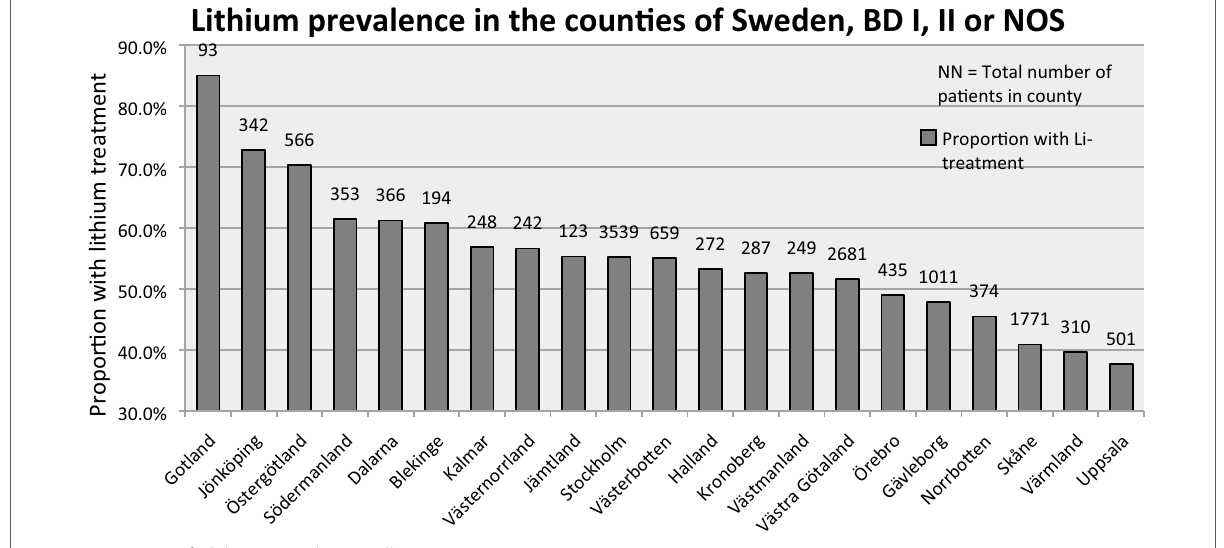
Fig. 2 County specific lithium prevalences. All BD